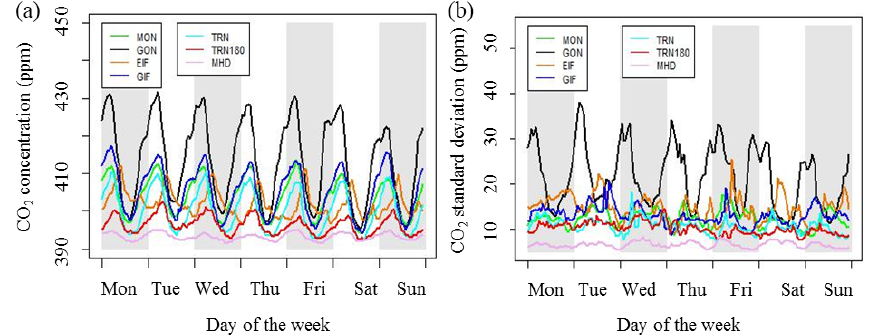
Figure 7. (a) CO 2 diurnal cycle by day of the week at the different stations, calculated from CO 2 hourly concentrations over the whole period of study. (b) Standard variation (1 σ) of the hourly CO 2 mean